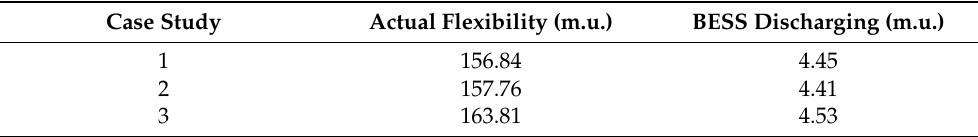
Table 4. Total remuneration according to a single approach.